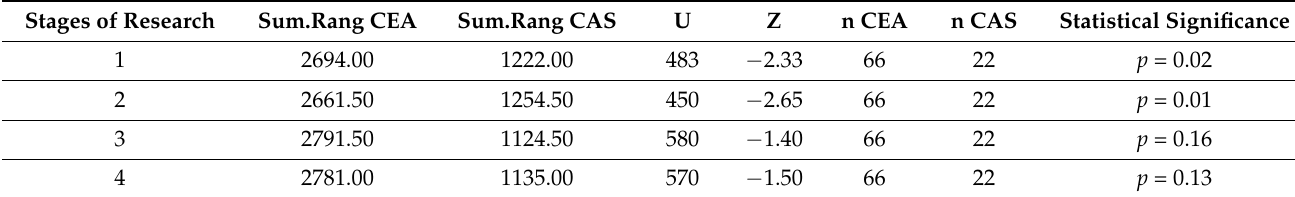
Table 2. Comparative analysis of the concentration of the S100 β protein according to the type of surgery.